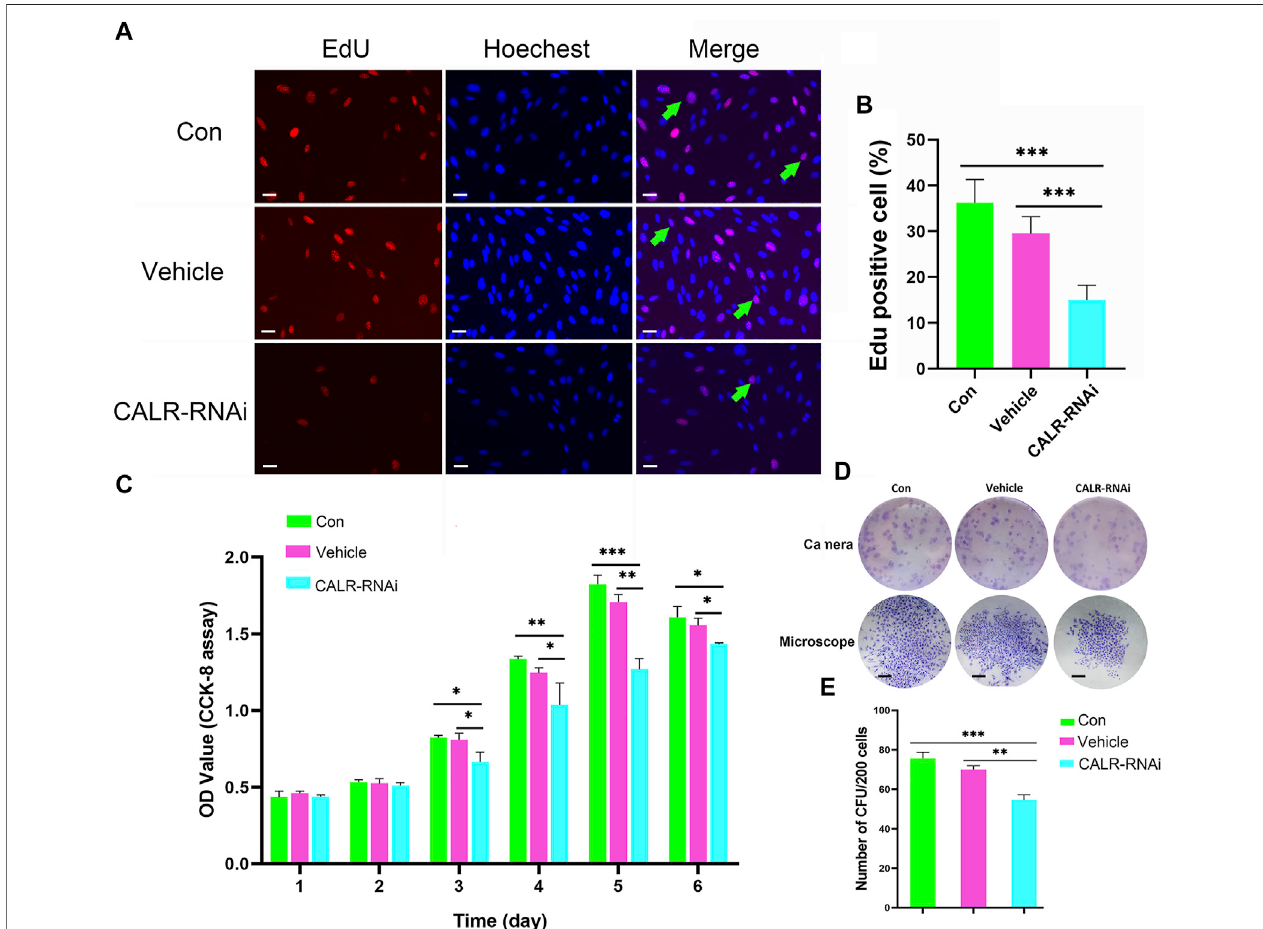
FIGURE8| EffectsofCALRdownregulationonAcPPcellproliferation. (A) Proliferationcells(red fl uorescence)intheAcPPofdifferenttreatmentgroupsdetermined by EdU incorporation assay; Scale bar = 25 µm. (B) Percentage of EdU positive cells; it is to be noted that EdU positive cells were signi fi cantly fewer in the CALR-RNAi group than those inthe other groups (*** p < 0.001). (C) Proliferation ofAcPP cells evaluated by CCK-8 assay on 6-day incubation. (D) Colony-forming units (CFUs) (top) and a single CFU (bottom) formed by different groups of AcPP cells on day 14 (scale bar = 500 µm). (E) Number of CFUs; it is to be noted that CFUs in the CALR- RNAi group were signi fi cantly fewer than those in the other groups. ** p < 0.01 and *** p < 0.001.